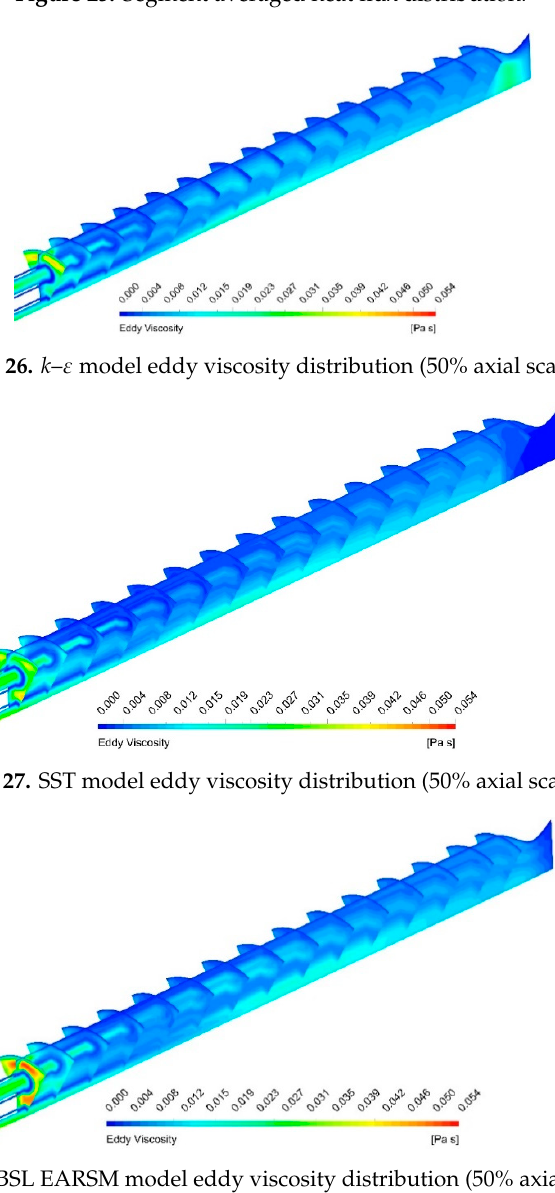
Figure 25. Segment averaged heat flux distribution.